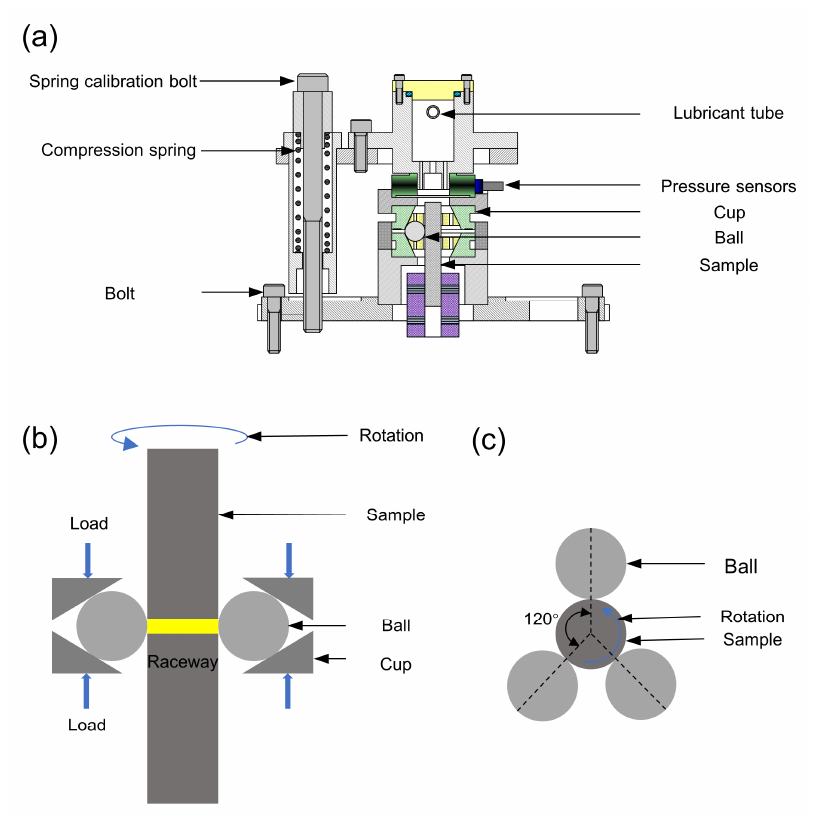
Figure 1. Schematic diagram of the ball-rod rolling contact fatigue tester: ( a ) cross-section of the ball-rod RCF tester; ( b , c ) tester schematic.